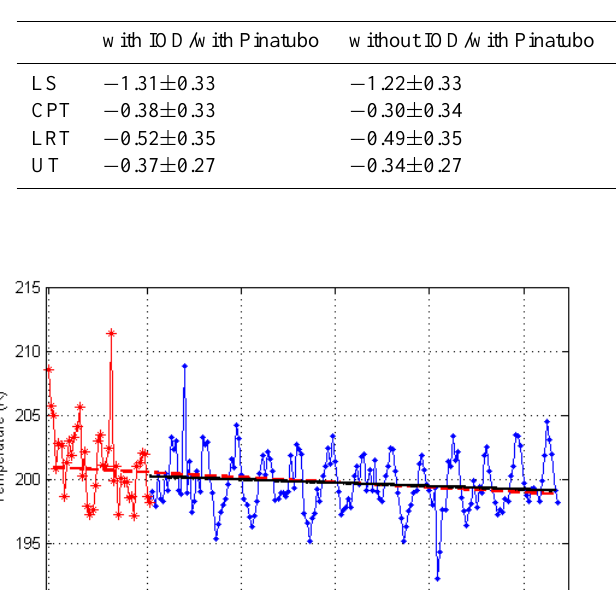
Table 3. Temperature trends (in Kelvin per decade) at UT, LRT, CPT and LS as computed by the Trend-Run model from radiosonde observations at Reunion Island. The model takes into account AO, SAO, QBO, ENSO and 11-year solar cycle. This table illustrates temperature trends with (first and third column) and without (second and fourth column) including the IOD forcing in the model, and with (first and second column) and without (third and fourth column), taking into account the post-Pinatubo data. The averaged coefficient of determination R 2 is about 0.75.